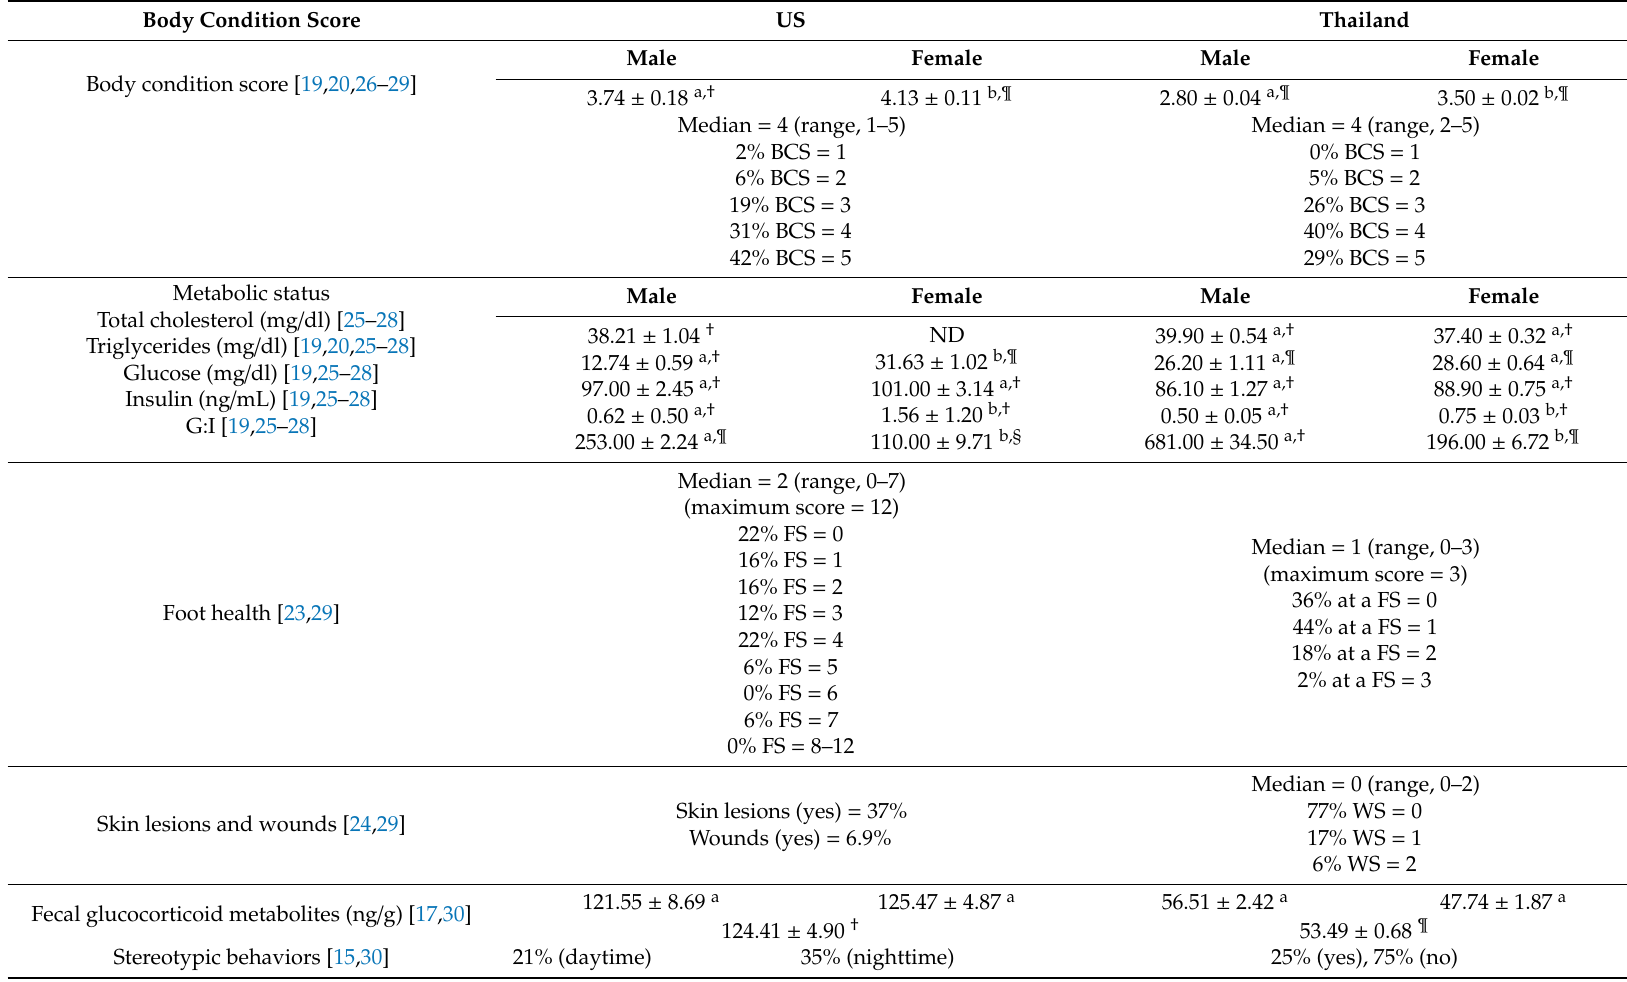
Table 2. Mean ( ± SEM) values for physical and physiological measures in Asian elephants involved in epidemiological welfare studies in North America and Thailand. Body Condition